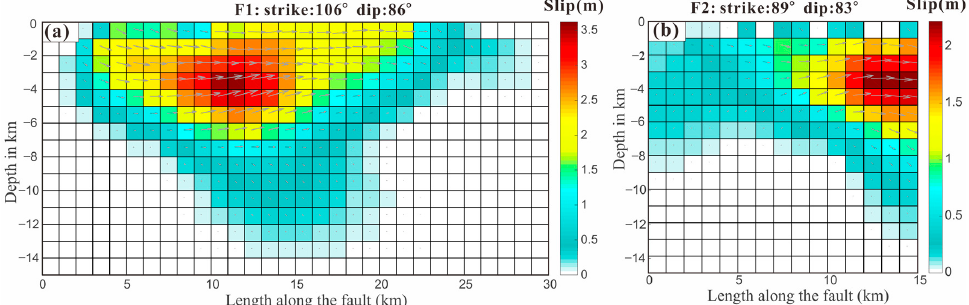
Figure 6. Optimal slip distributions of the 2022 earthquake event.